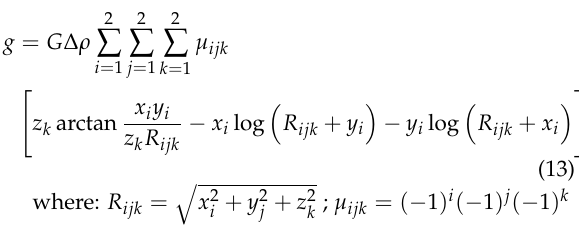
(Fig. 8). Based on these results, the separation of regional moving average filter with a 5 km × 5 km window